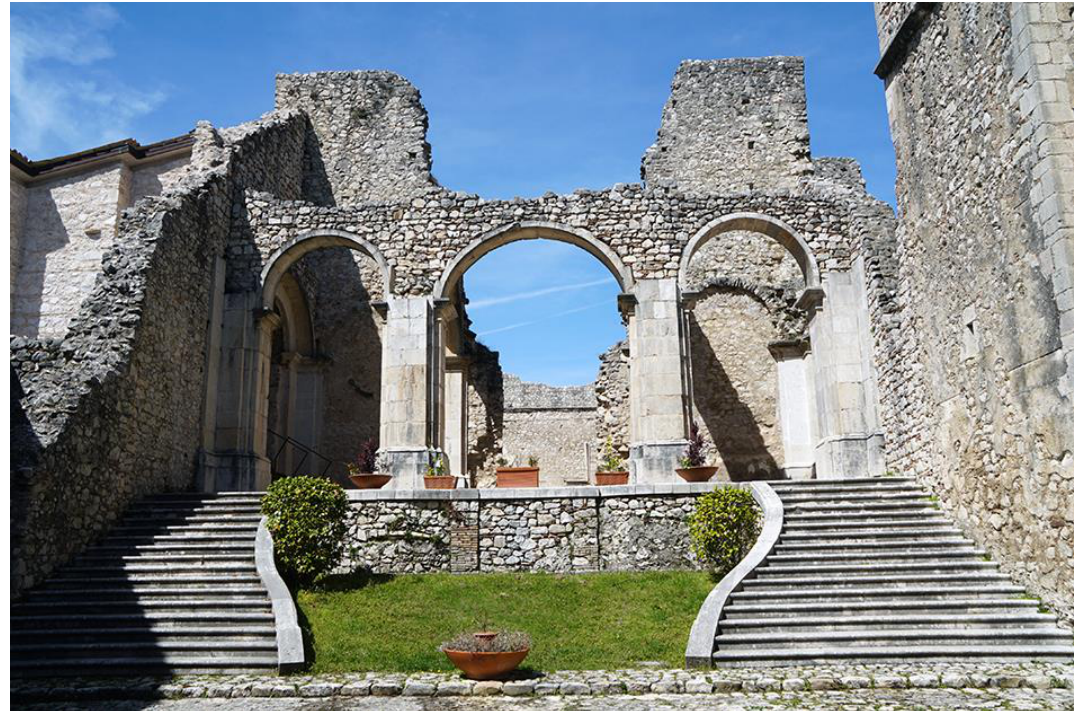
Figure 36. Sant’Angelo dei Lombardi: the remains of the Goleto Abbey (photos by [35,36]).